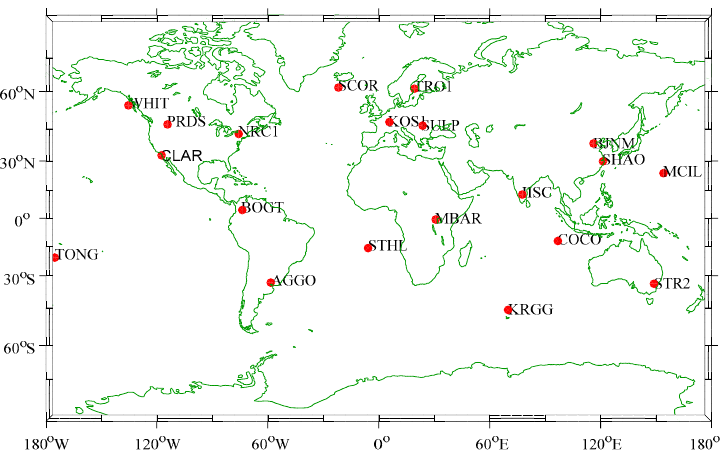
Figure 5. 20 IGS stations around the world for kinematic RT-PPP positioning assessment.